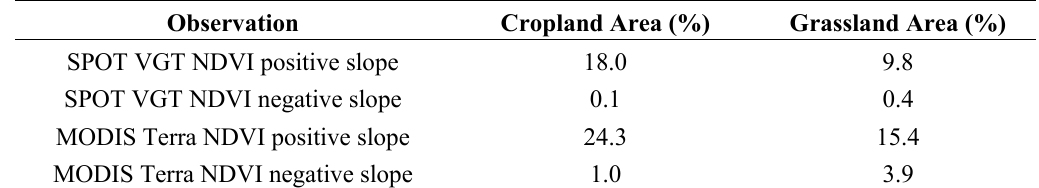
Table 2. Statistics for SPOT VGT and MODIS Terra NDVI linear trend analysis from 2001 to 2010 ( p < 0.05, MSK